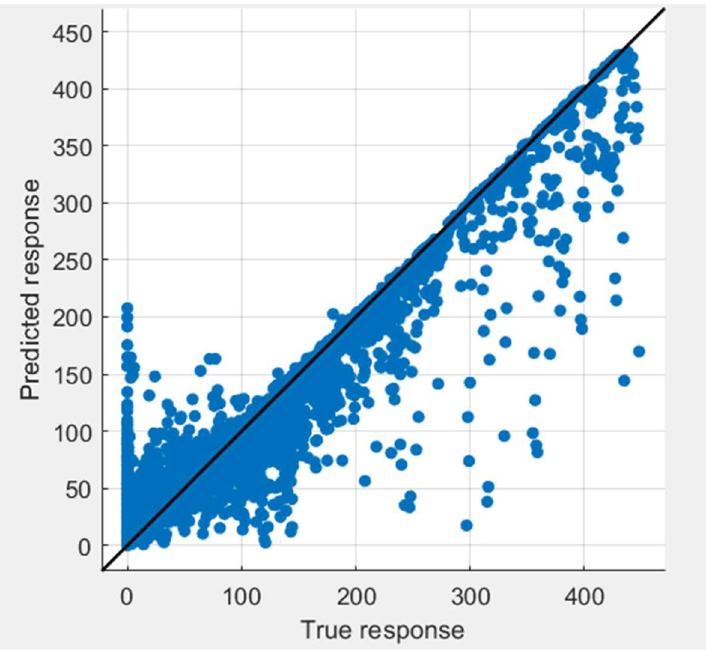
Figure 7. Prediction trend for interval C, without CVA optimization.